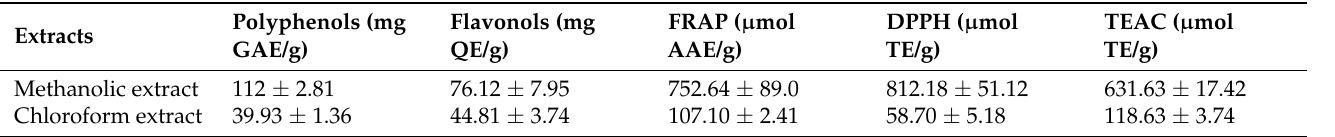
Table 1. Phenolic compounds and antioxidant capacity of the methanolic extract and chloroform crude extracts of E. africanus